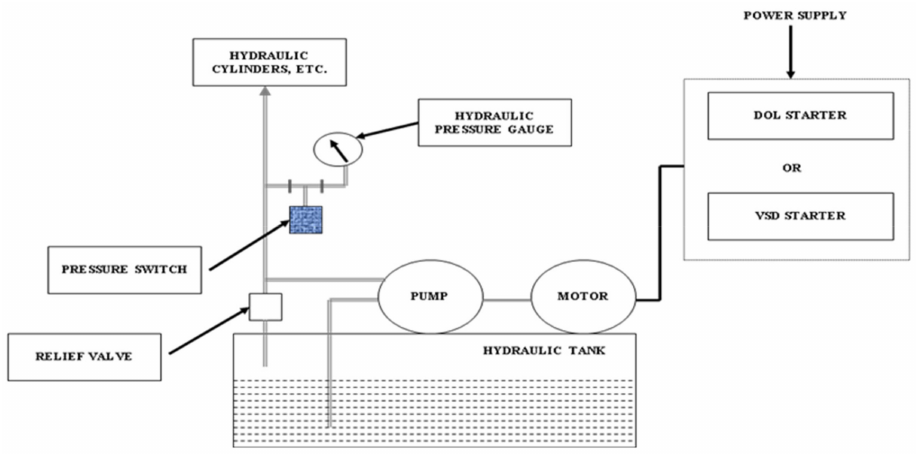
Figure 2. Basic components of a hydraulic pump system.